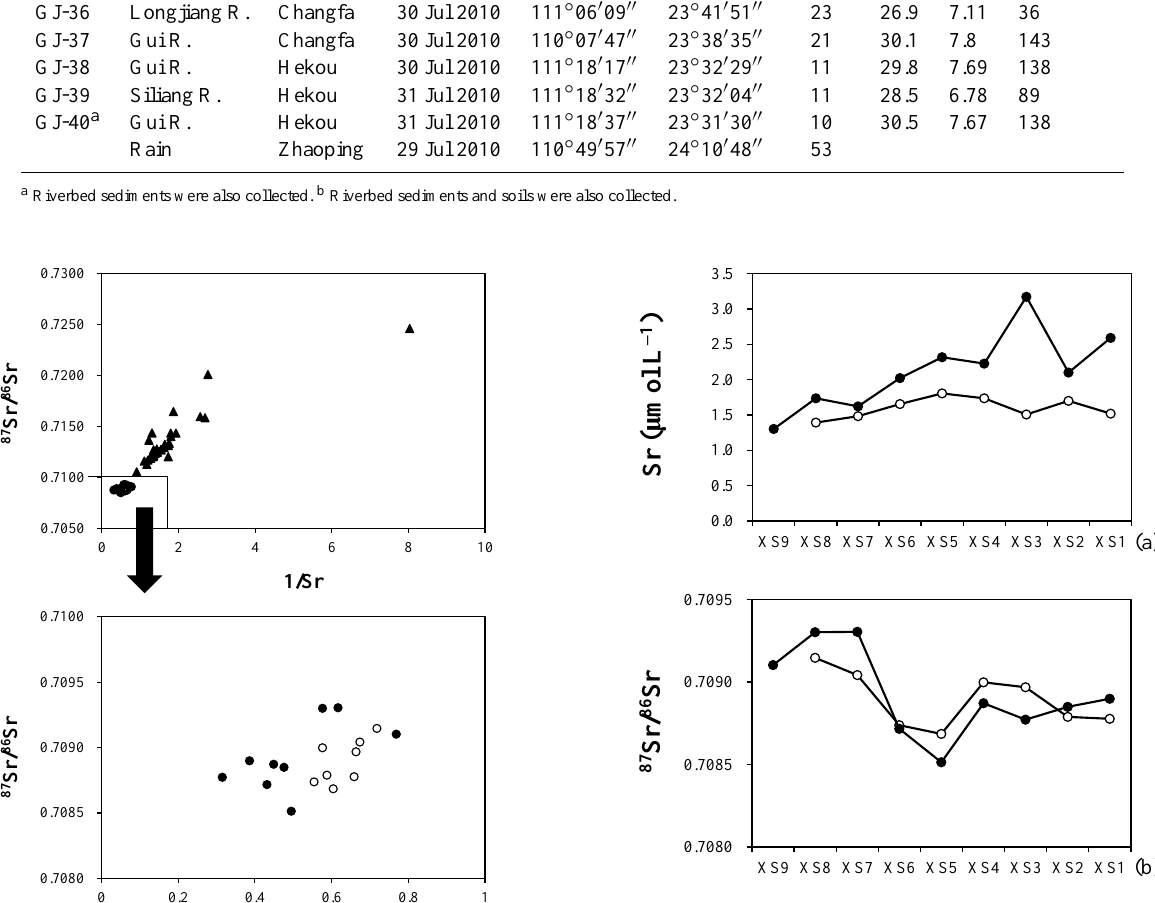
Fig. 6. Temporal and spatial variations of the Sr concentrations (a) and the 87 Sr / 86 Sr ratios (b) in the Xishui River. The filled and open circles represent the samples in the winter and summer,